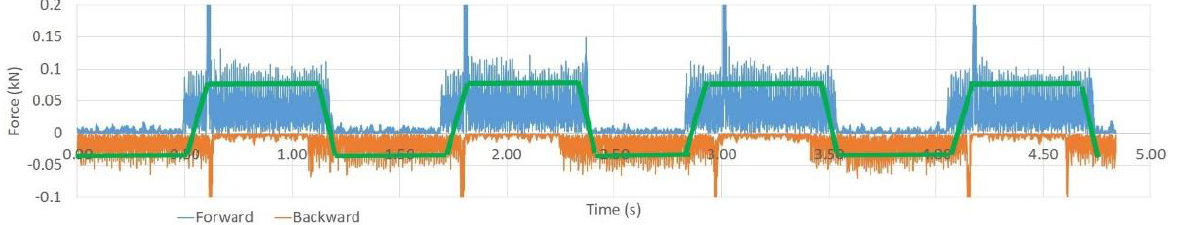
Figure 4. Recording forces when handling the saw (vertical — red colour, forward — cyan colour, and backward — yellow colour).